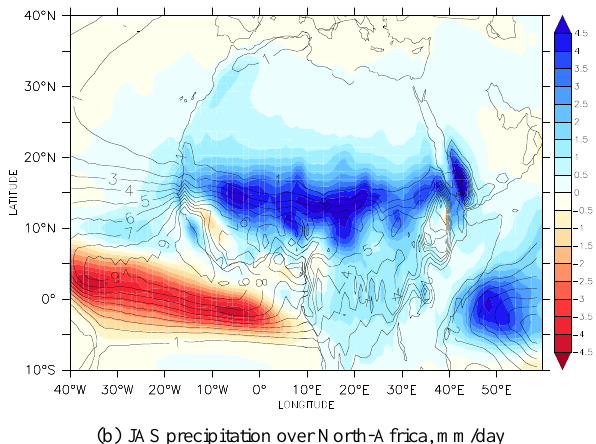
Fig. 6. (a) Precipitation (mmday − 1 ) for PI (black), MH (red) and Fig. 6. Figure (a): Precipitation (mm/day) for PI (black), MH (red) difference MH-PI (blue) throughout the year. The dashed blue lines and difference MH-PI (blue) throughout the year. The dashed blue are differences in the PMIP2 models: the thick dashed blue line lines are differences in the PMIP2 models: the thick dashed blue is the average of 12 PMIP2 models (see Fig. 15 for references). line is the average of 12 PMIP2 models (see Figure 15 for refer- The thin dashed blue lines are individual PMIP2 model results with ences). The thin dashed blue lines are individual PMIP2 model re- the largest and smallest changes for North-Africa in JAS. (b) The sults with the largest and smallest changes for North-Africa in JAS. spatial pattern of precipitation differences in JAS. Colours indicate Figure (b): the spatial pattern of precipitation differences in JAS. MH-PI differences, contours are absolute PI Colours indicate MH - PI differences, contours are absolute PI val- ues.